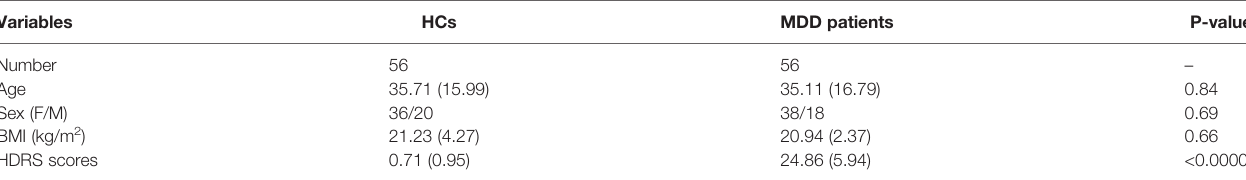
TABLE 1 | Demographic data of the recruited